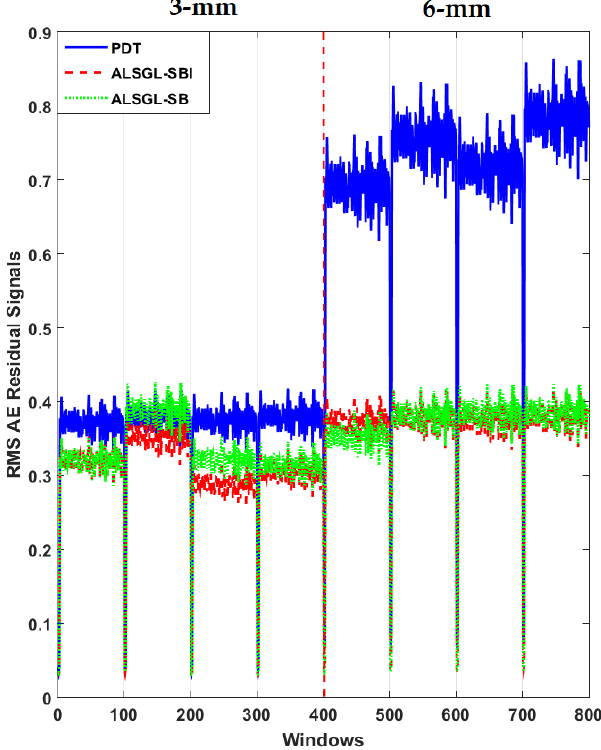
Figure 23. RMS of resampled AE residual signals for crack size (3 mm and 6 mm) diagnosis for inner–outer–ball conditions using ALSGL-SB, ALSGL-SBI and PDT methods.